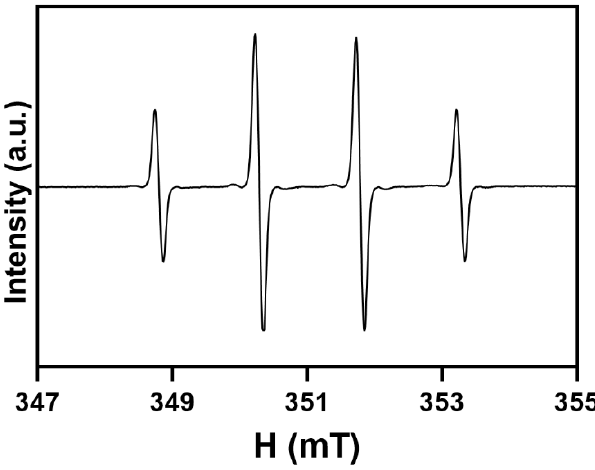
Figure 1. A typical EPR spectrum of the DMPO – OH